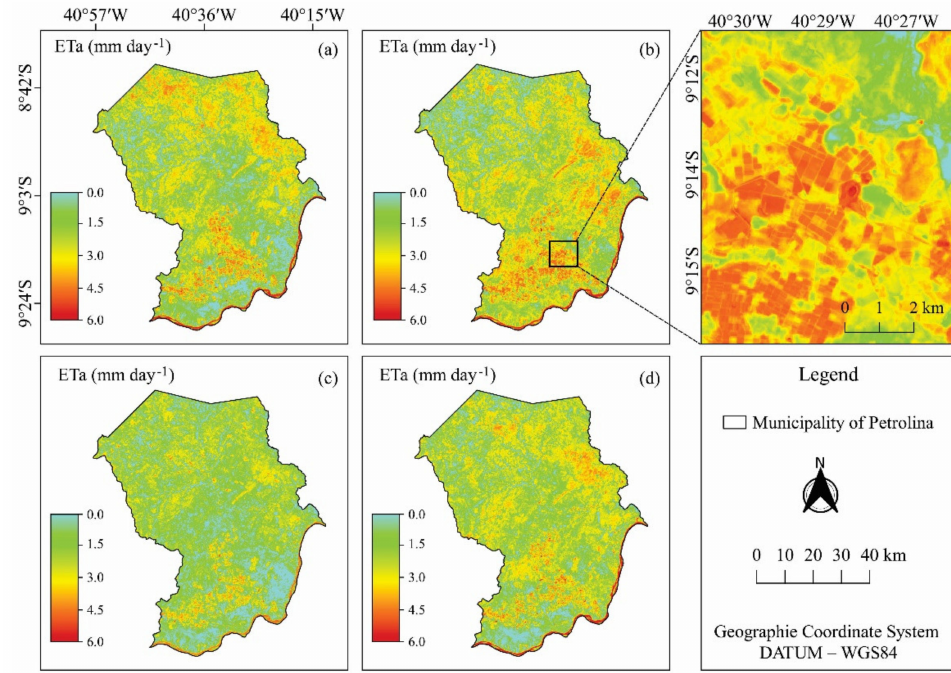
Figure 9. Spatiotemporal distribution of actual evapotranspiration (ET a , mm day − 1 ), calculated with Surface Energy Balance Algorithm for Land (SEBAL), in the municipality of Petrolina, Pernambuco, Brazil, on the imaging dates 5 October 2013 ( a ), 12 November 2015 ( b ), 16 October 2017 ( c ), and 7 November 2019 ( d